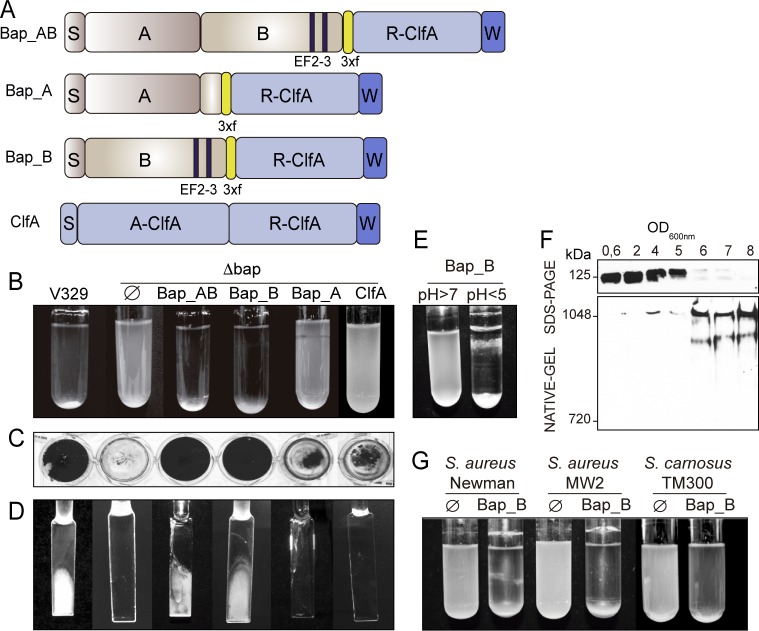
Region B of Bap is sufficient to promote biofilm development.A) Structural organization of Bap chimeric proteins. S, signal peptide; A, region A; B, region B. EF2-3, EF-hand calcium binding motifs 2 and 3; 3xf, 3xFlag tag; R-ClfA, clumping factor R domain; A-ClfA, clumping factor A domain; W, cell wall anchor. B) Bacterial clumping of overnight cultures grown under shaken conditions (200 rpm) at 37°C. C) Biofilm formation in microtiter plates under static conditions. D) Biofilm formed on glass slides under flow culture conditions using microfermentors. E) Bacterial clumping of S. aureus Δbap mutant expressing Bap_B chimeric protein. Cells were cultured in LB (pH>7) and LB-glu (pH<5). F) Western immunoblotting results demonstrating that Bap_B chimeric protein is sufficient to induce insoluble aggregates. Cell wall extracts from Δbap mutant expressing Bap_B chimeric protein grown in LB-glu were separated on 7.5% acrylamide gels (upper panel) or Criterion XT Tris-acetate gels with Tris/glycine running buffer (lower panel) and probed with anti-Bap antibodies. G) Bacterial clumping of S. aureus Newman, S. aureus MW2 and S. carnosus TM300 complemented with the plasmid carrying the Bap_B chimeric protein or with empty plasmid (Ø). Bacteria were cultured overnight at 37°C with agitation in LB-glu. For assays performed with S. aureus Δbap expressing the chimeric proteins of Bap, media were all supplemented with 1 μM of CdCl2. Cell clumps and biofilm from 3 independent experiments were quantified (S1B Fig).